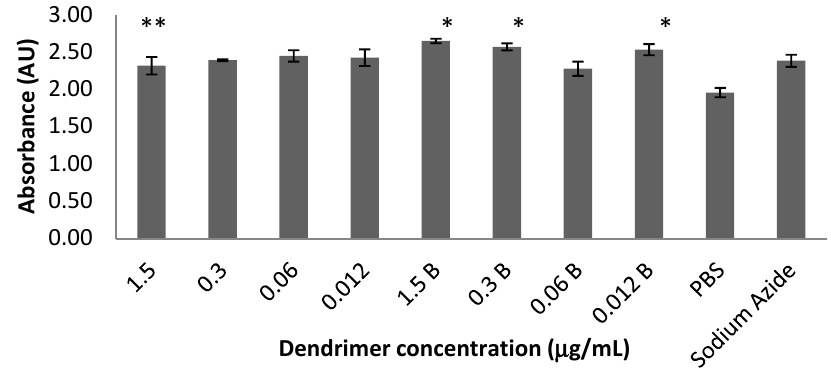
Figure 1. Biotinylated G4 PAMAM dendrimers induce toxicity in the in vitro BBB model at the 48 h time point. There was no notable difference between the non-biotinylated dendrimers and cells treated with phosphate buffered saline (PBS; negative control) or sodium azide (positive control). Ryan’s (R-E-G-W-Q) post-hoc analyses revealed the following differences: * p < 0.05 when compared to PBS controls; ** p < 0.05 when compared to 1.5 μ g/mL biotinylated dendrimers. All of the biotinylated dendrimers except 0.06 µg/mL were toxic when compared to PBS, and none differed from sodium azide, indicating cell toxicity. Bars 1–4 represent non-biotinylated dendrimers and bars 5–8 represent biotinylated dendrimers. Values represent means ±